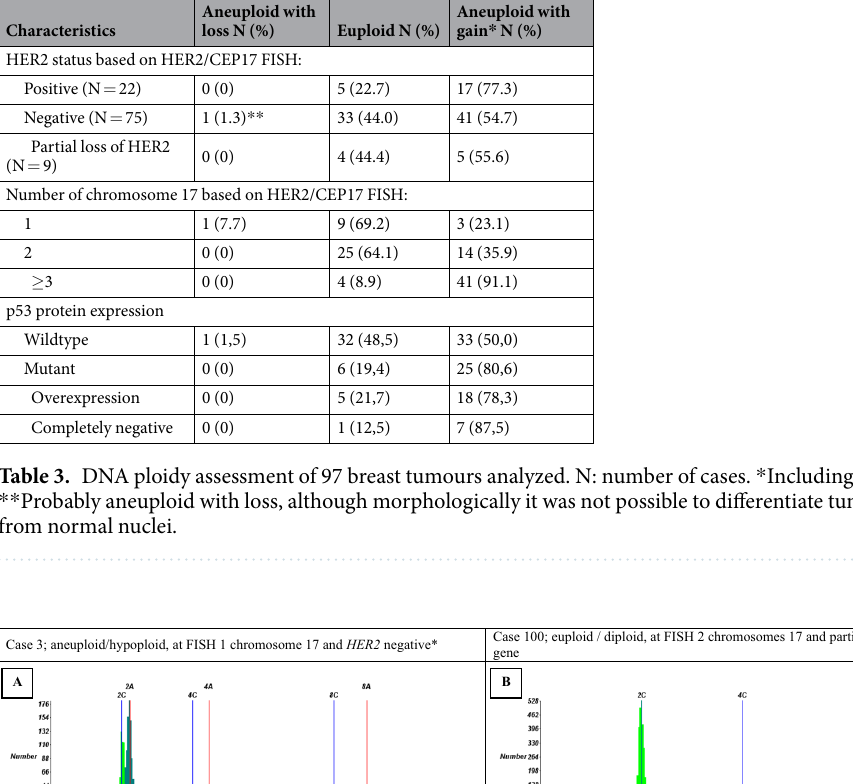
Case 3; aneuploid/hypoploid, at FISH 1 chromosome 17 and HER2 negative*